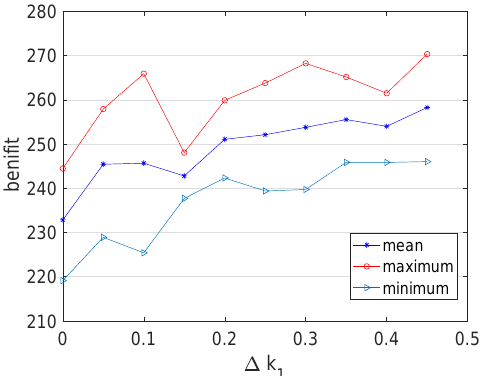
Figure 5. The changes in the total benefit with the increase in ∆ k 1 (a step of 0.05).